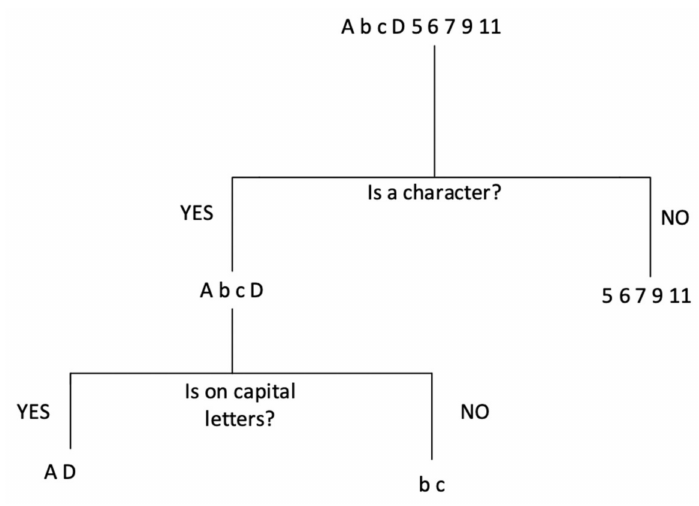
Figure 5. Example of how a decision tree in RF